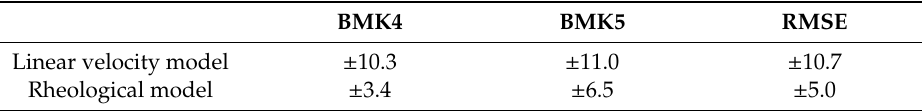
Figure 13. Time-series deformation results compared with leveling measurements on benchmarks: ( a ) BMK 4 in Figure 3a, and ( b ) BMK 5. Table 3. RMSE comparison on benchmarks